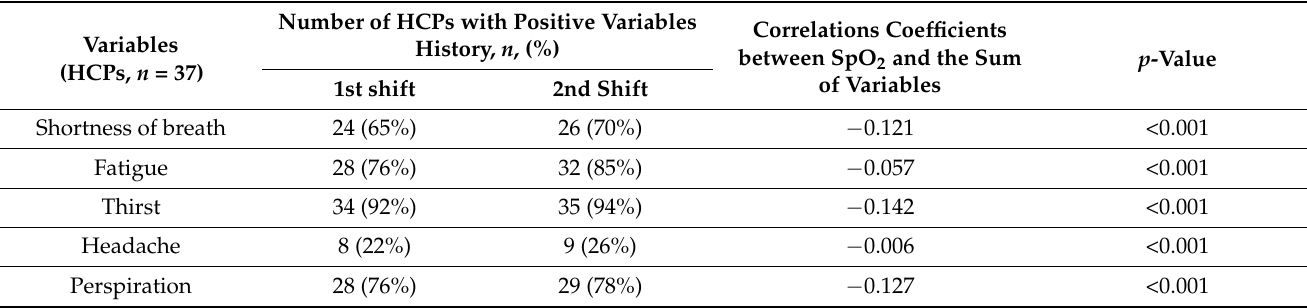
Table 4. Spearman’s correlation coefficients between SpO 2 and the variables describing HCPs well- being, assessed in the study ( n = 37,